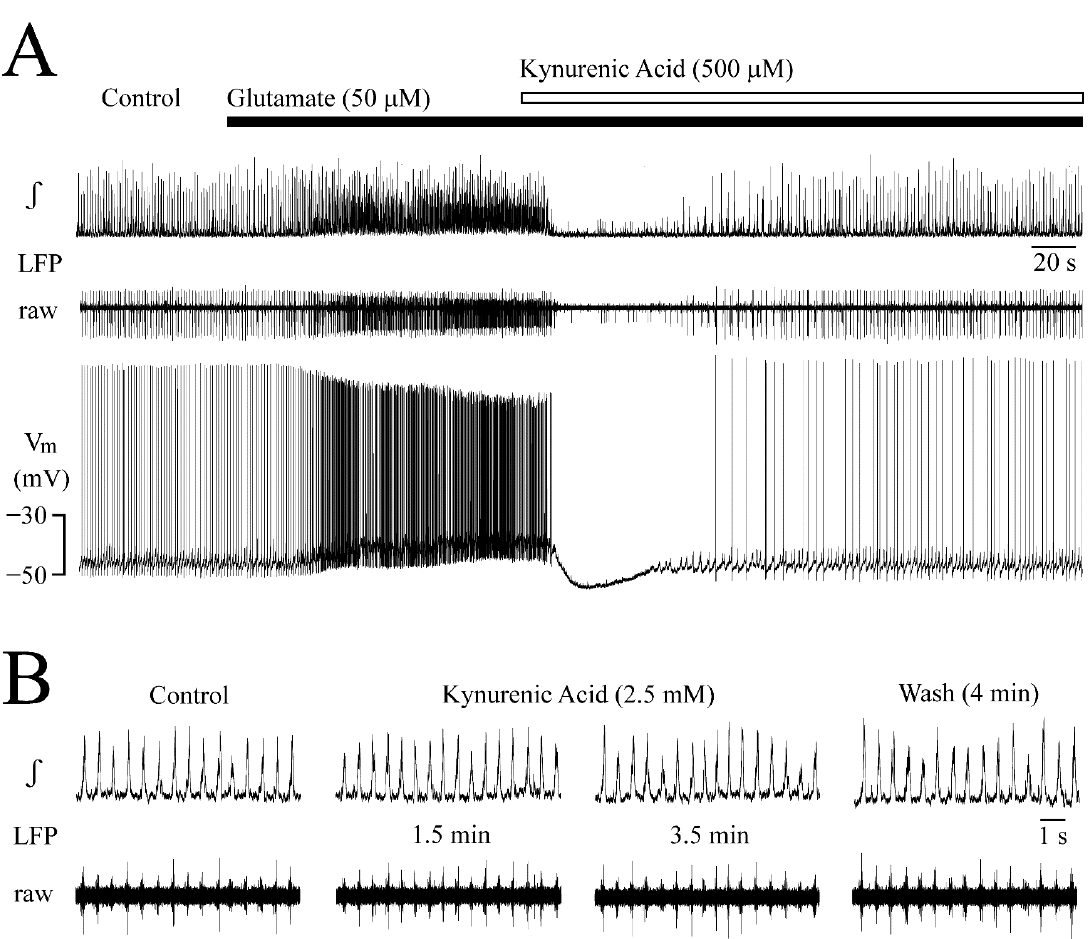
Figure 10. Receptor-specificity of glutamate effects. ( A ) Shows for the same neuron illustrated in Figure 6 the LFP pattern-transforming response to glutamate on a condensed time scale. In the initial phase of application of the non-selective ionotropic glutamate receptor blocker kynurenic acid (500 μ M), LFP and neuronal spiking were abolished along with a pronounced hyperpolarization. Subsequently, LFP, V m and intracellular spiking recovered to control levels during continuous application of kynurenic acid in glutamate. ( B ) The initial inhibitory kynurenic acid action on LFP and neuron discharge depended on the presence of glutamate as an addition of the drug to control superfusate had no effect on LFP, as measured in a different